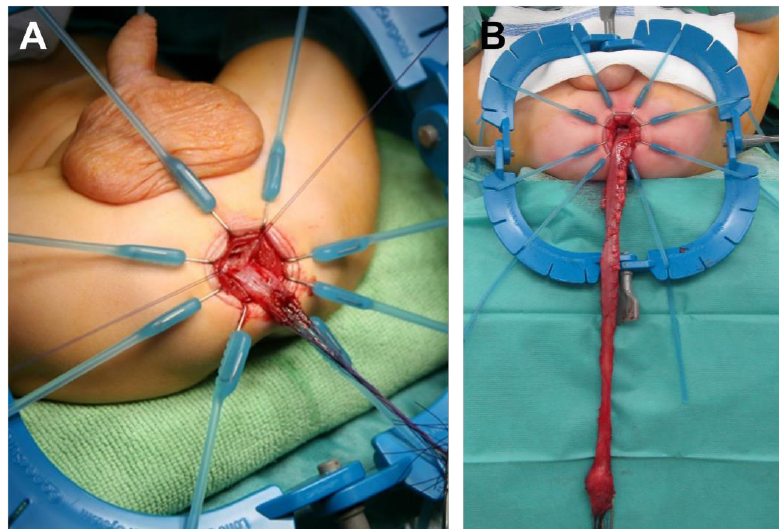
Figure 2. Submucosal preparation ( A ) and full-thickness dissection without entering the transition zone ( B ). This is continued until the transition zone is reached. Full-thickness frozen biopsies are taken immediately cranial to this segment to confirm ganglion cells.